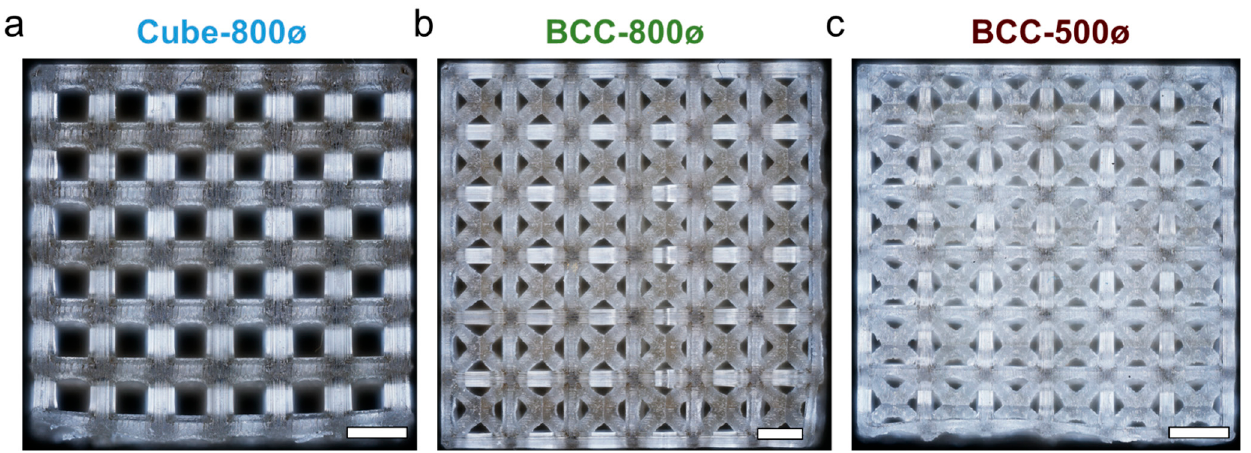
Figure 8. Microscopy of lattice side face for a representative sample of ( a ) Cube-800ø, ( b ) BCC-800ø, and ( c ) BCC-500ø designs. Scale bars approximately 2 mm.